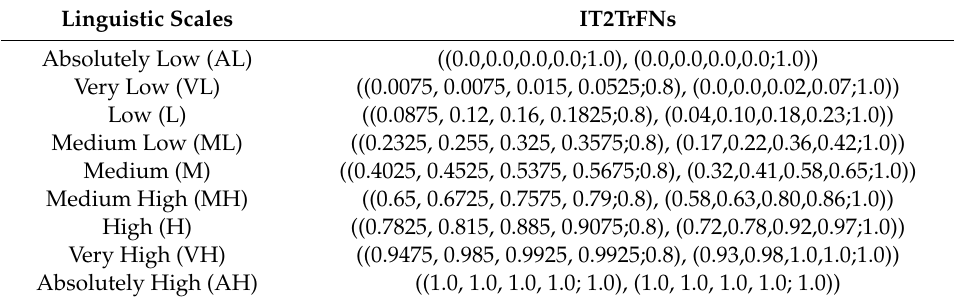
Table A6. Linguistic scales and fuzzy numbers for the factors.